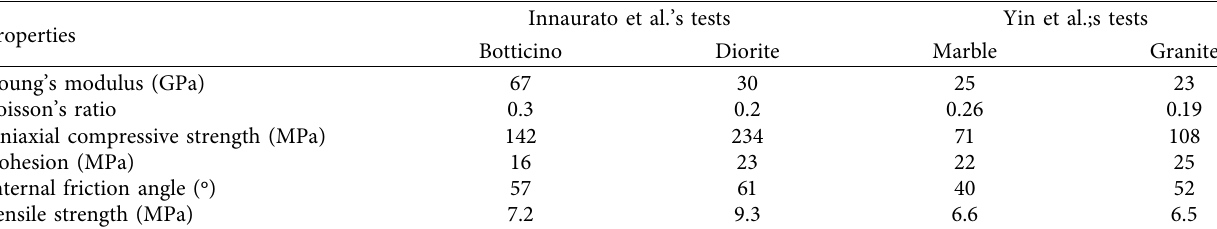
Table 2: Physical and mechanical properties of the tested rocks adopted in Innaurato et al.’s laboratory tests and Yin et al.’s laboratory tests. Yin et al.;s tests Properties Botticino Diorite Marble